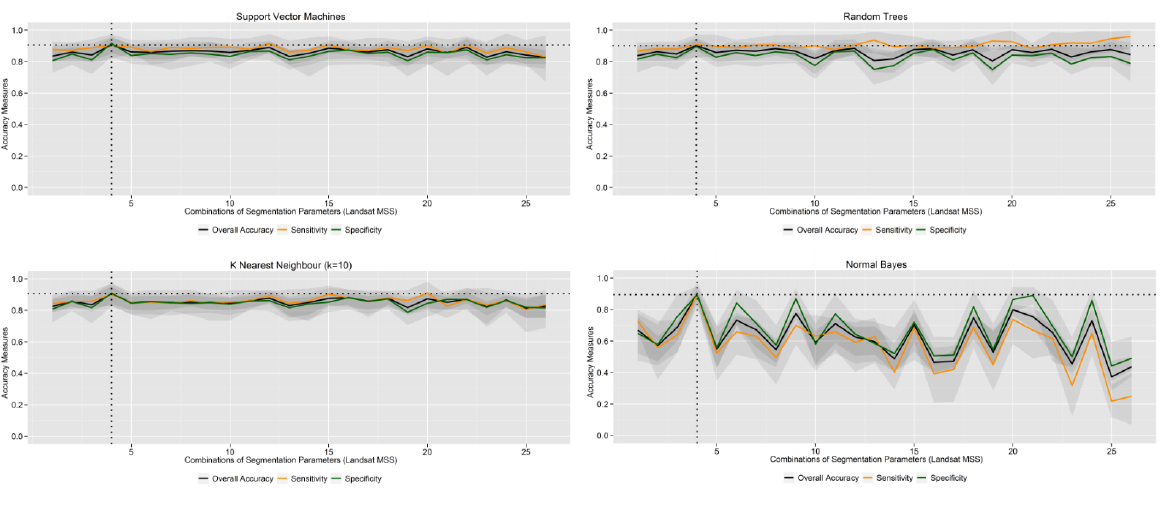
Figure 16. Influence of the segmentation inputs on the classification accuracy for MSS with increasing average segment size from left to right. Mean and range of accuracy measures from the ten-fold cross-validation are shown for each